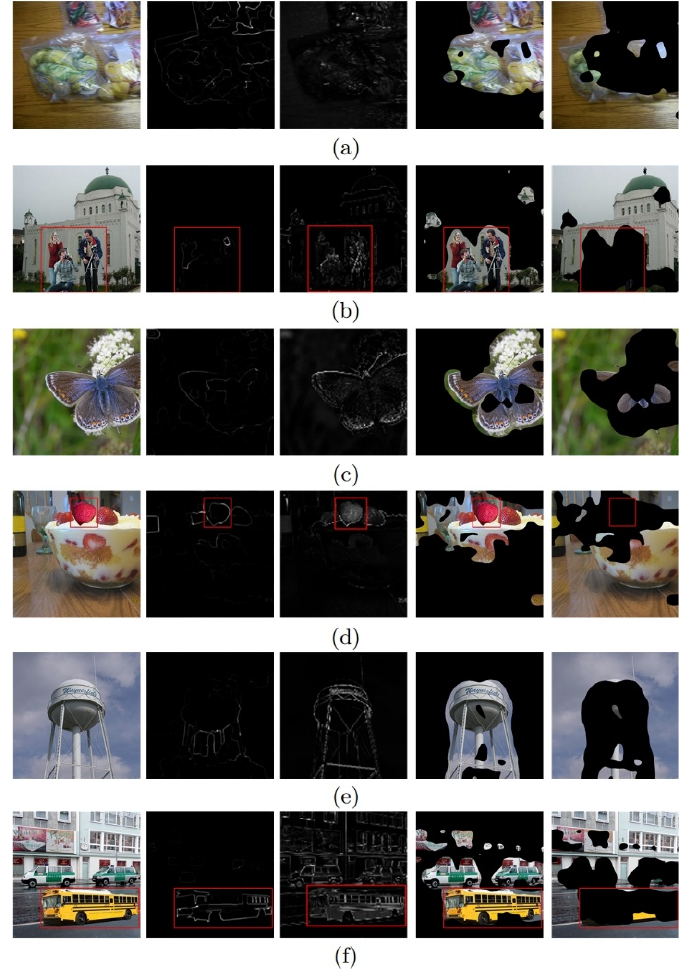
Figure 10. The extracted features of the proposed algorithm. From left to right are the color images, the chroma detection results of CCW, the results of the sharpness detection operator, and the ROI and RONI given by the CCW salient map. ( a , c , e ) Untampered images; ( b , d , f ) tampered images. See Table 1 for details.